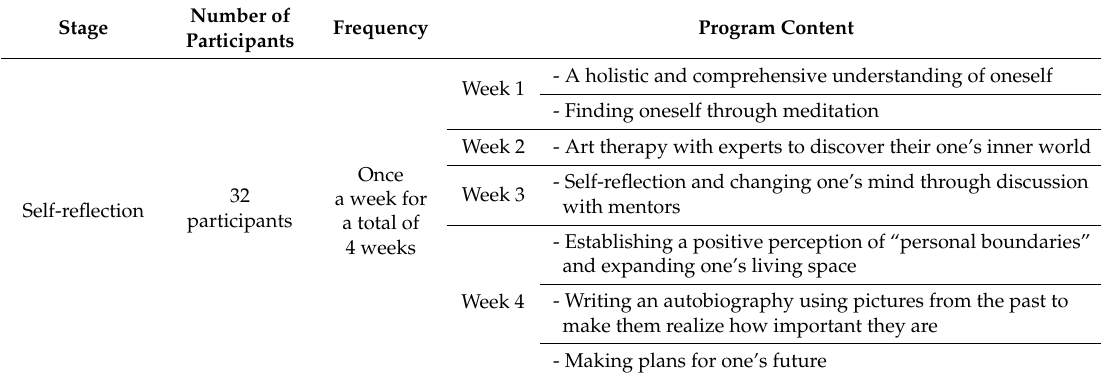
Table 2. Details of the Self-Reflection stage.